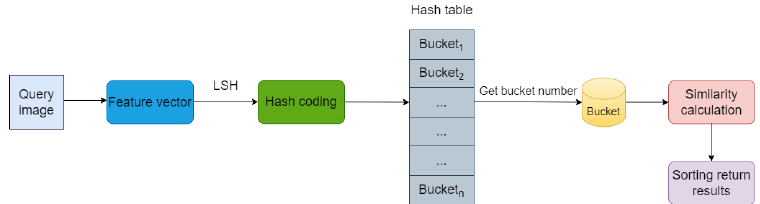
Figure 9. LSH lookup